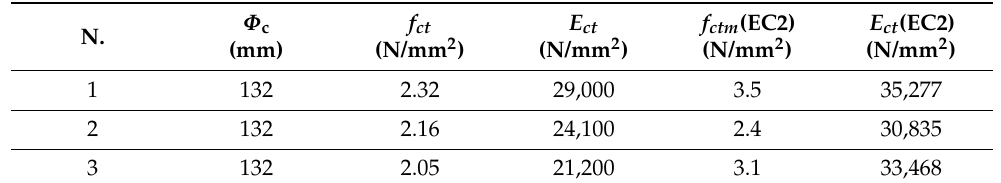
Table 4. Results of direct uniaxial tensile tests on concrete specimens. N.